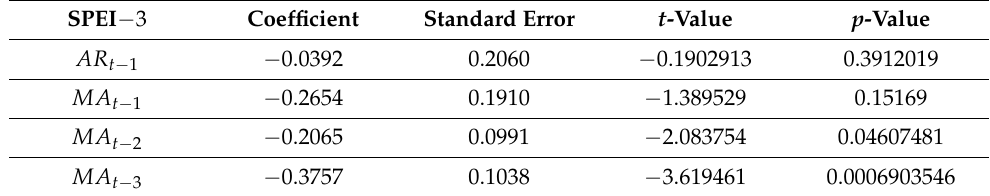
Table 7. SPEI-3 ARIMA (1,1,3)(0,0,0) for Seasonal.